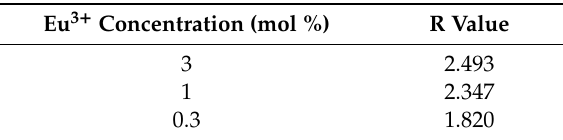
Table 1. Comparison of asymmetry ratios in relation to doping concentration in di ff erent Eu 3 + :BGO